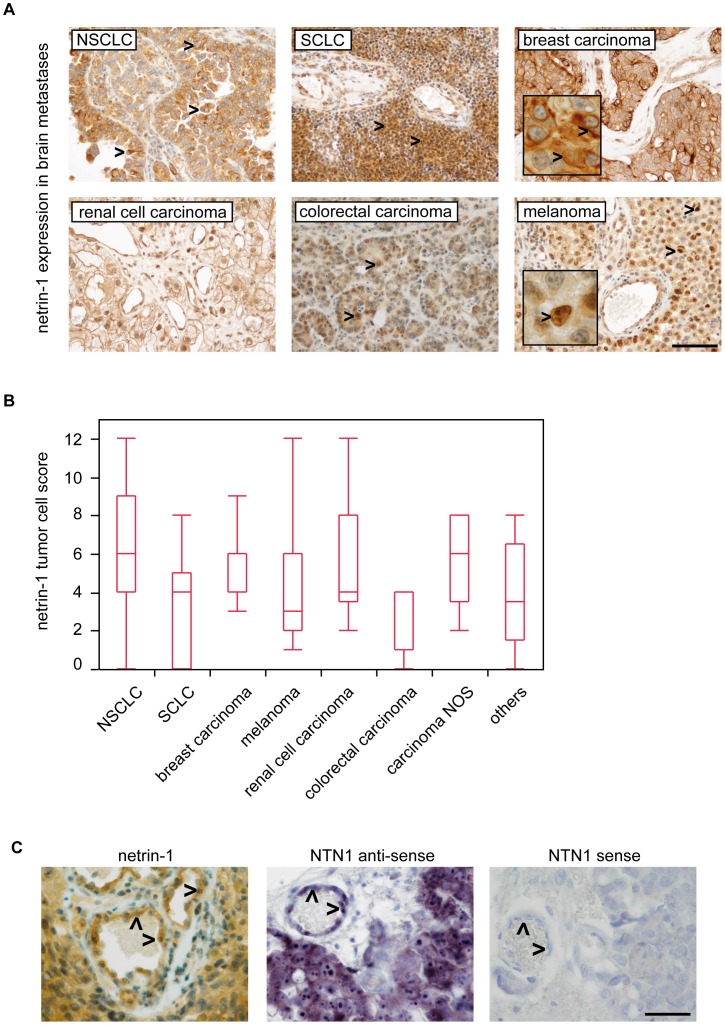
Netrin-1 is strongly expressed in tumor cells of human brain metastases.Arrowheads in (A) indicate different subcellular localisation. Brain metastases of NSCLC and SCLC show strong cytoplasmic staining, while the depicted breast carcinoma shows an additional membraneous signal (see blow up and arrowheads). Nuclear localization is exemplarily shown in melanoma (see blow up and arrowhead) and colon cancer metastases samples (scale bar 100 μm). Box plots of netrin-1 tumor cell scores are shown in (B) (see also Table S1). In-situ hybridization reveals tumor cells and endothelial cells (arrowheads) as source for netrin-1 expression (C: example of a SCLC, scale bars 50 μm).